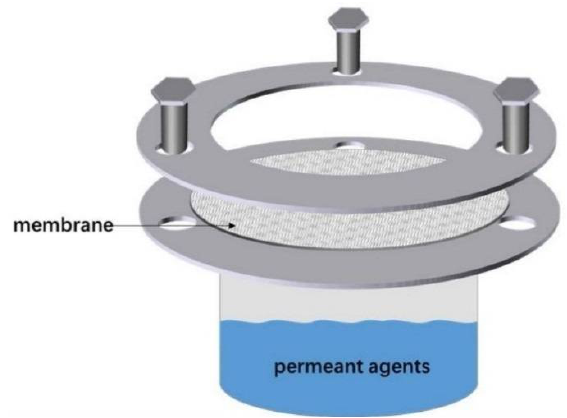
Figure 1. Schematic drawing of the permeation